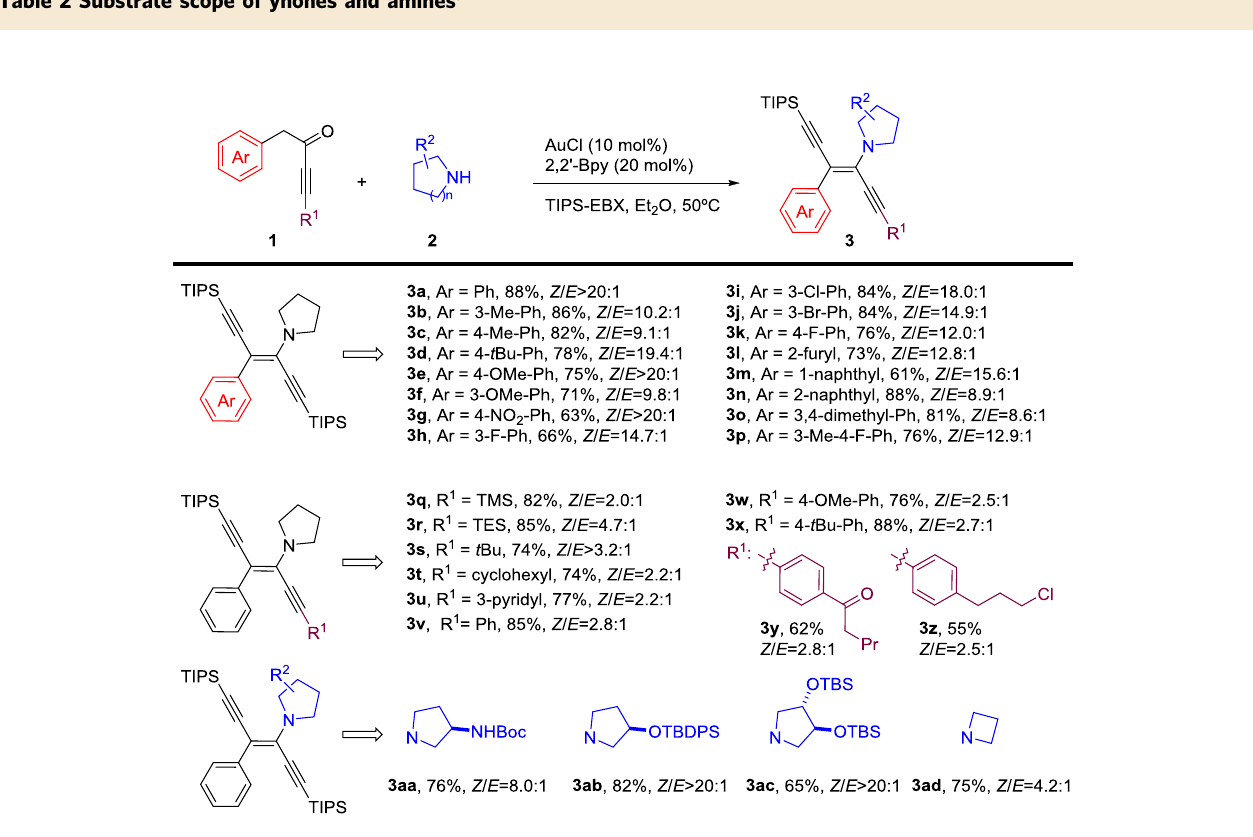
Table 2 Substrate scope of ynones and amines a